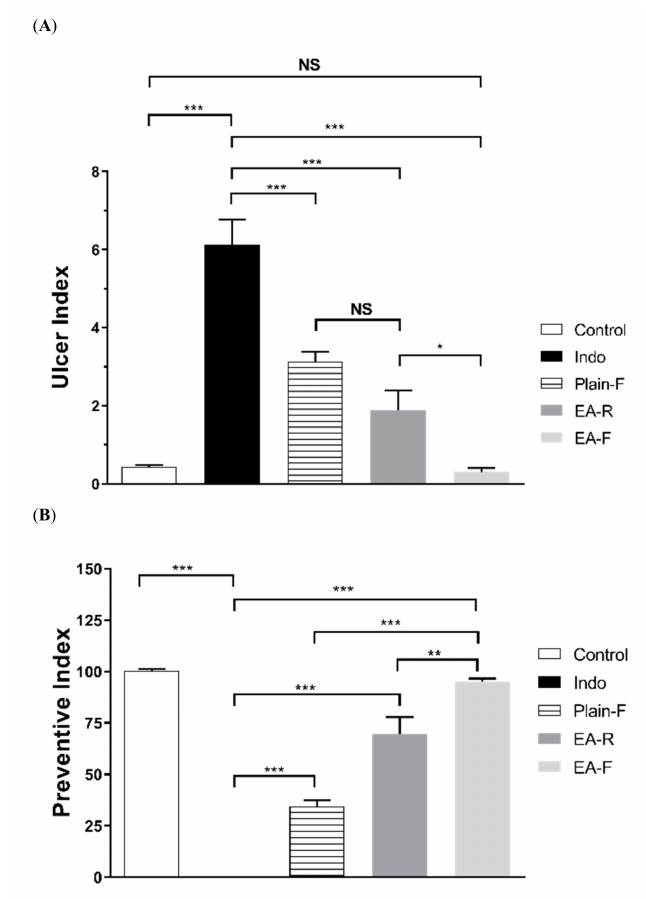
Figure 6. The e ff ect of indomethacin, plain formula, raw EA and optimized EA–Ca pectinate formula on ulcer index ( A ) and ulcer inhibition percent (preventive index) ( B ). Data are presented as mean ± SEM. Significantly di ff erent at * p < 0.05, ** p < 0.01, *** p < 0.001. Indo: indomethacin, Plain-F: Plain formula, EA-R: pure ellagic acid, EA-F: ellagic acid formula.